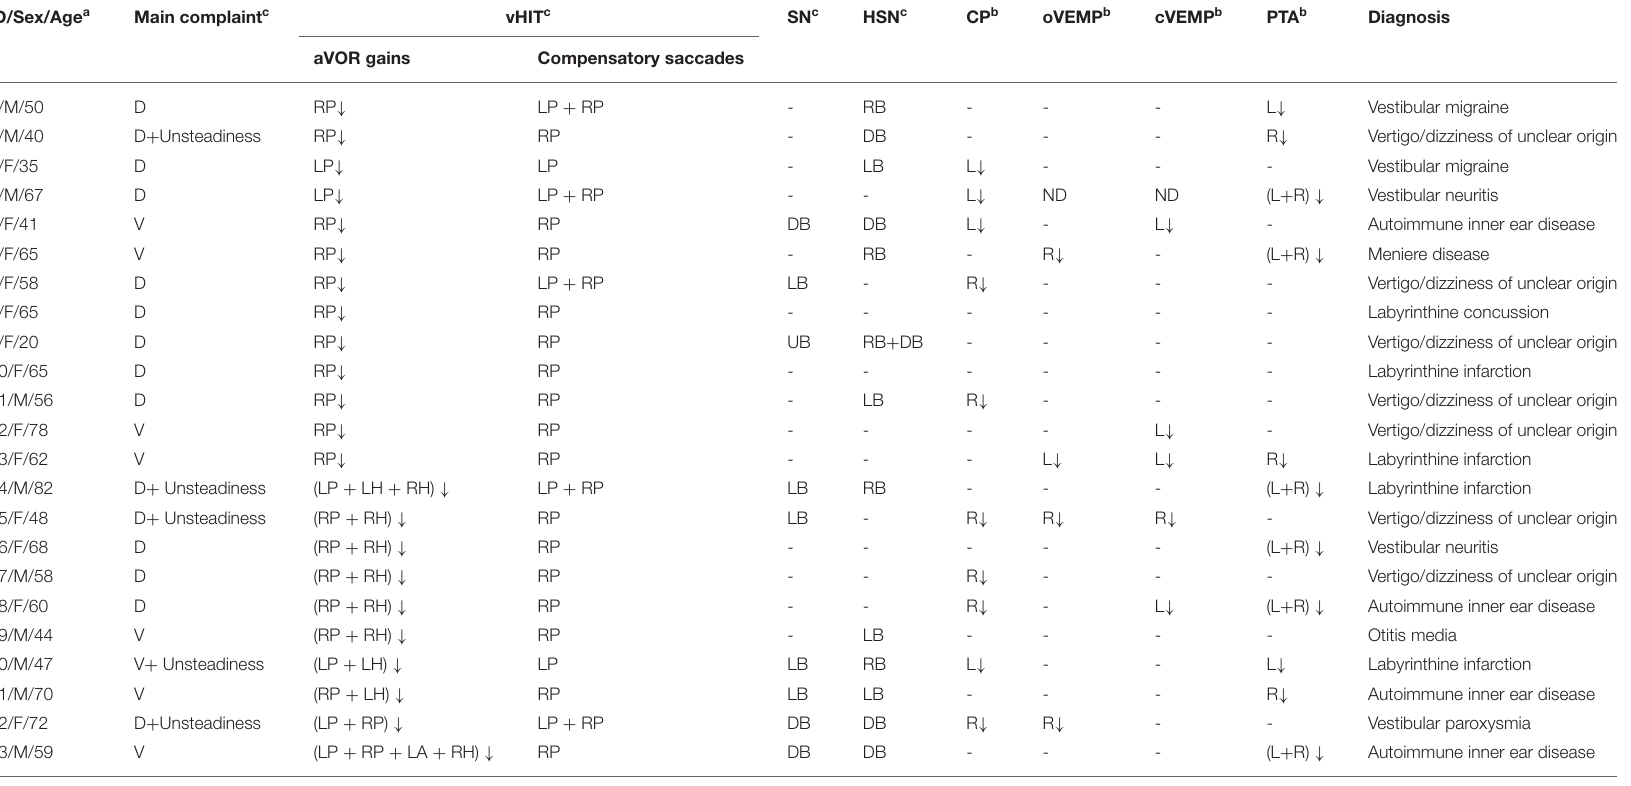
TABLE 5 | Vestibulo-cochlear test and underlying diagnoses in patients with ILPC on